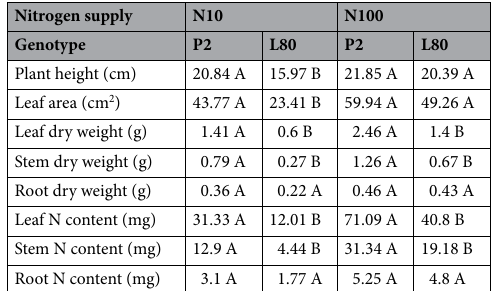
Table 1. Nitrogen content and growth-associated traits of two contrasting inbred popcorn lines under low (N10) and high (N100) nitrogen levels. The average followed by the same capital letters between genotypes inside N-levels did not differ significantly by the Tukey test ( P < 0.05, n = 4).